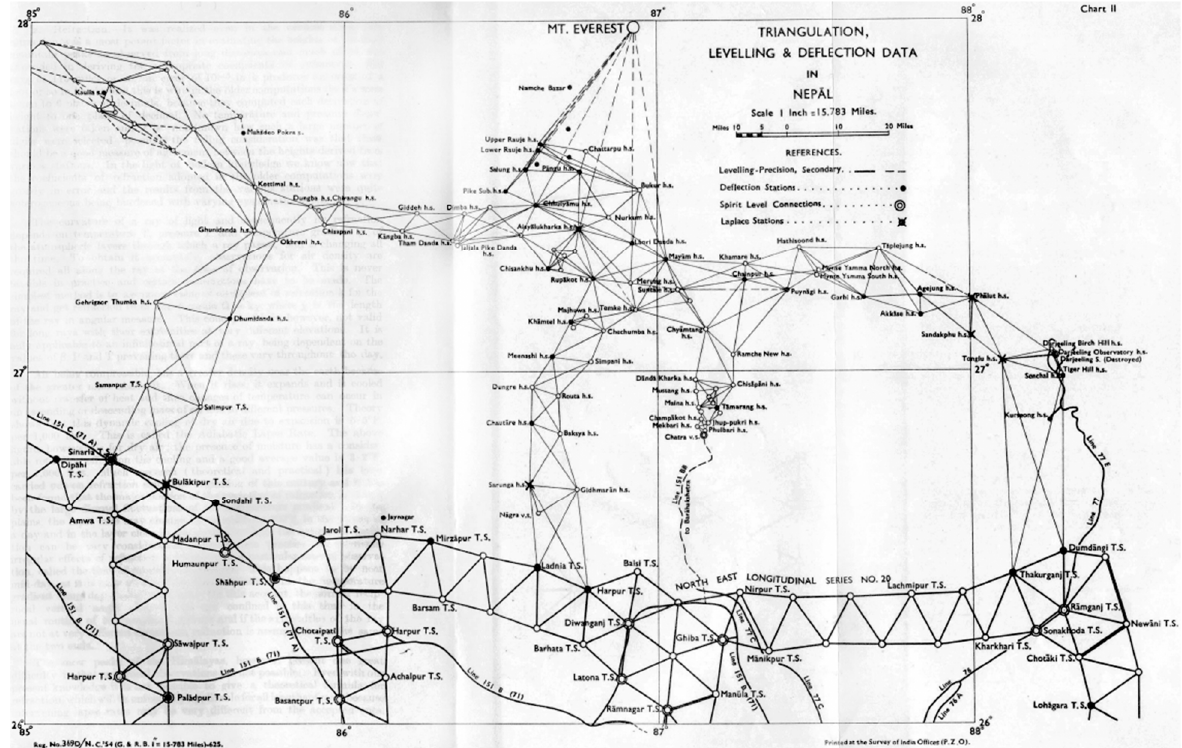
Figure 4. Triangulation network Everest height measurement 1952–1954 [6].